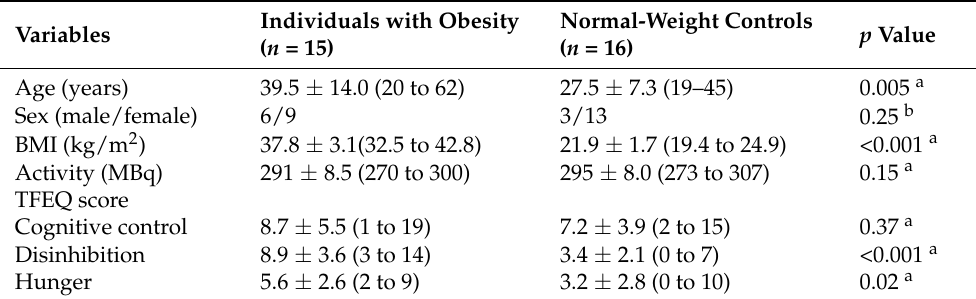
Table 1. Demographics and Three-Factor Eating Questionnaire scores of individuals with obesity and normal-weight